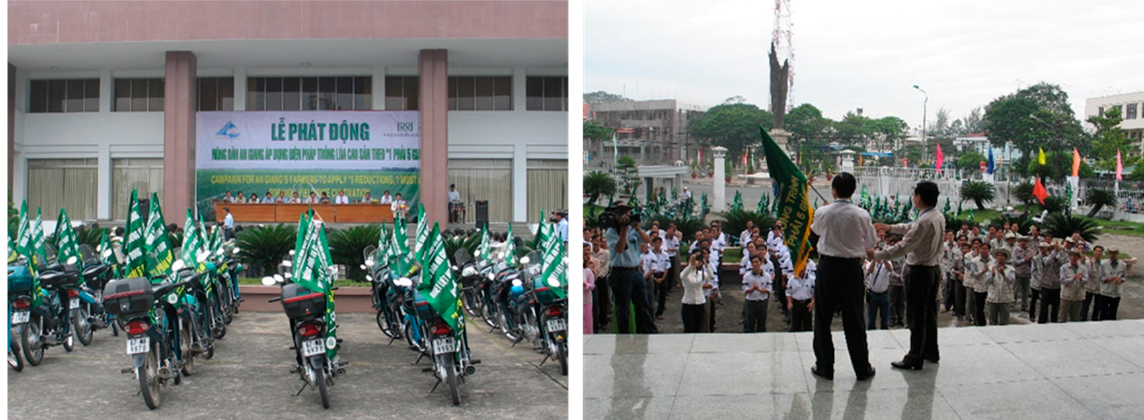
Figure 3. National launch of 1 Must Do, 5 Reductions (Mot Phai, Nam Giam) at Long Xuyen, An Giang, in November 2009.